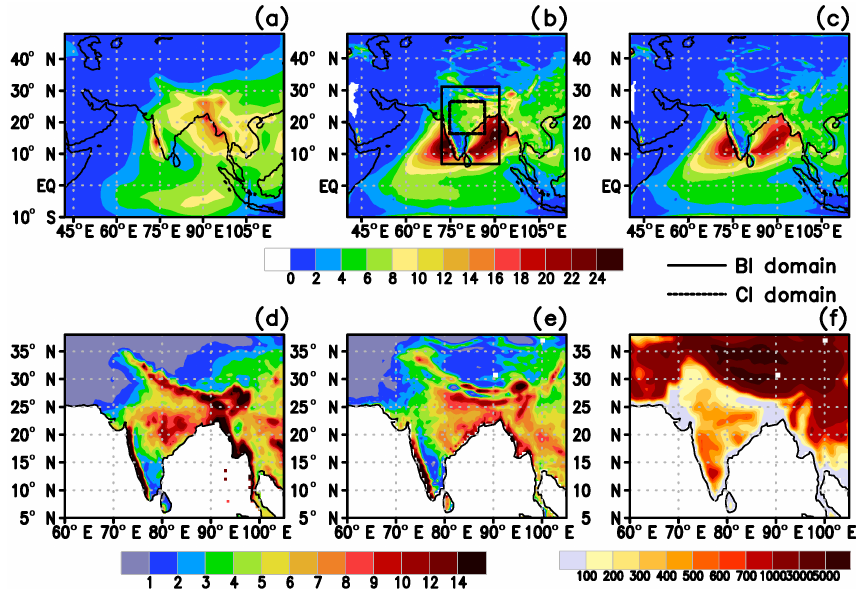
Figure 4. Seasonal (JJAS)-averaged rainfall (a) from GPCP (1982–2008), (b) in PLC experiment (1982–2008), (c) in PLCS experiment (1982–2008), and (d) based on APHRODITE data (1982–2007). (e) Seasonal-averaged rainfall only over land in PLC experiment. Units are in mmday − 1 . (f) Representation of orography in RegCM4. Units are in m.